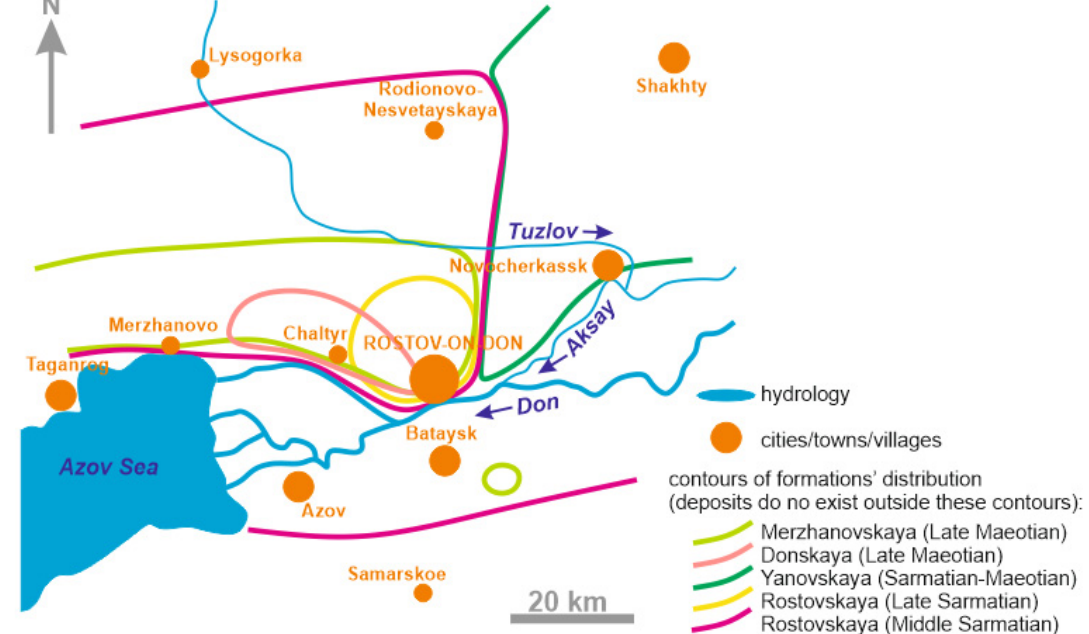
Figure 3. Synthesis of the knowledge of the present-day distribution of the Middle Sarmatian–Maeotian lithostratigraphical units within the Rostov Dome (created by the author; see text for additional explanations and data sources).